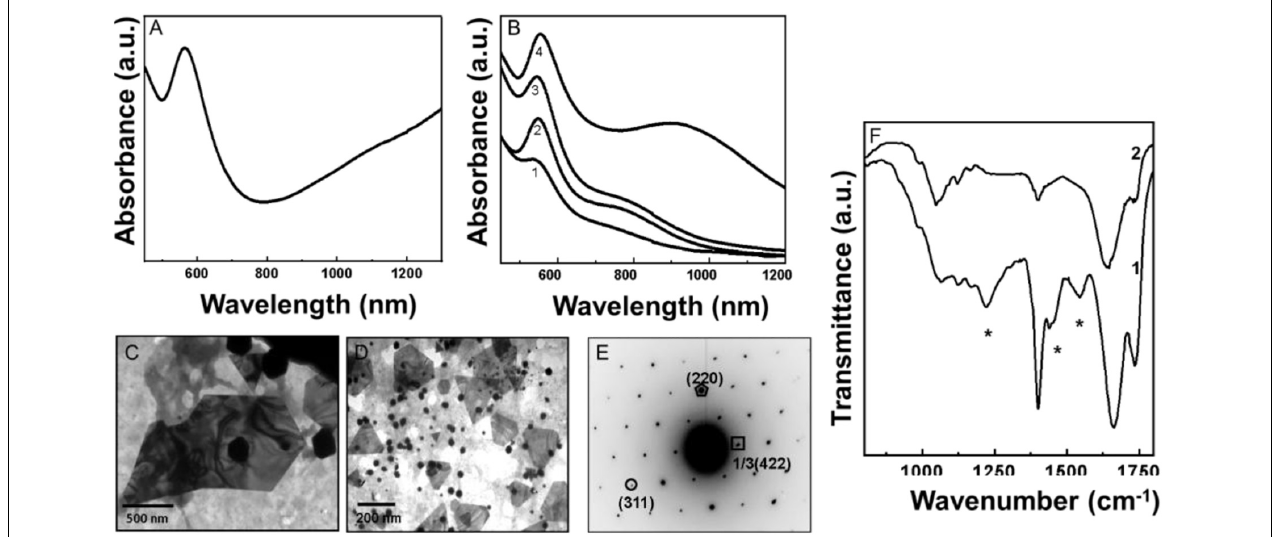
FIGURE 1 | Uv-Vis spectroscopy, transmission electron microscopy (TEM), and Fourier transformed infrared spectroscopy (FTIR) analysis of biologically synthesized pyoverdine gold nanoparticles (Pv-AuNPs). (A) The Uv-Vis spectrum of Pv-AuNPs obtained after 60 min of reaction. (B) Kinetics of Pv-AuNPs formation followed by Uv-Vis absorption spectroscopy. Number 1–4 corresponds to 15, 30, 45, and 60 min of reaction. (C,D) TEM analysis of Pv-AuNPs showing flat hexagonal and triangular nanoparticles. (E) Selected area diffraction (SAED) pattern obtained from the triangular nanoparticles (NPs) shown in (D) . The numbers in parenthesis indicate the respective crystal planes corresponding to face centered cubic (FCC) gold. (F) FTIR spectra recorded from pyoverdine before (curve 1) and after (curve 2) the formation of Pv-AuNPs showing absence of various band vibrations belonging to functional groups (shown as *) in pyoverdine after NPs